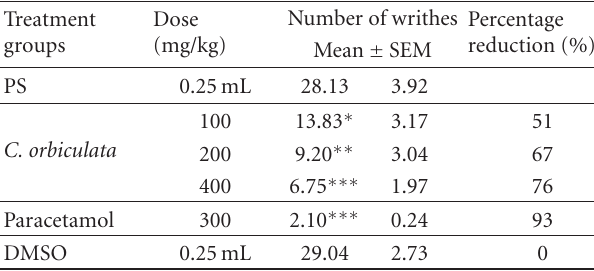
Table 1: E ff ect of leaf methanol extract of Cotyledon orbiculata on acetic acid-induced writhing in mice.